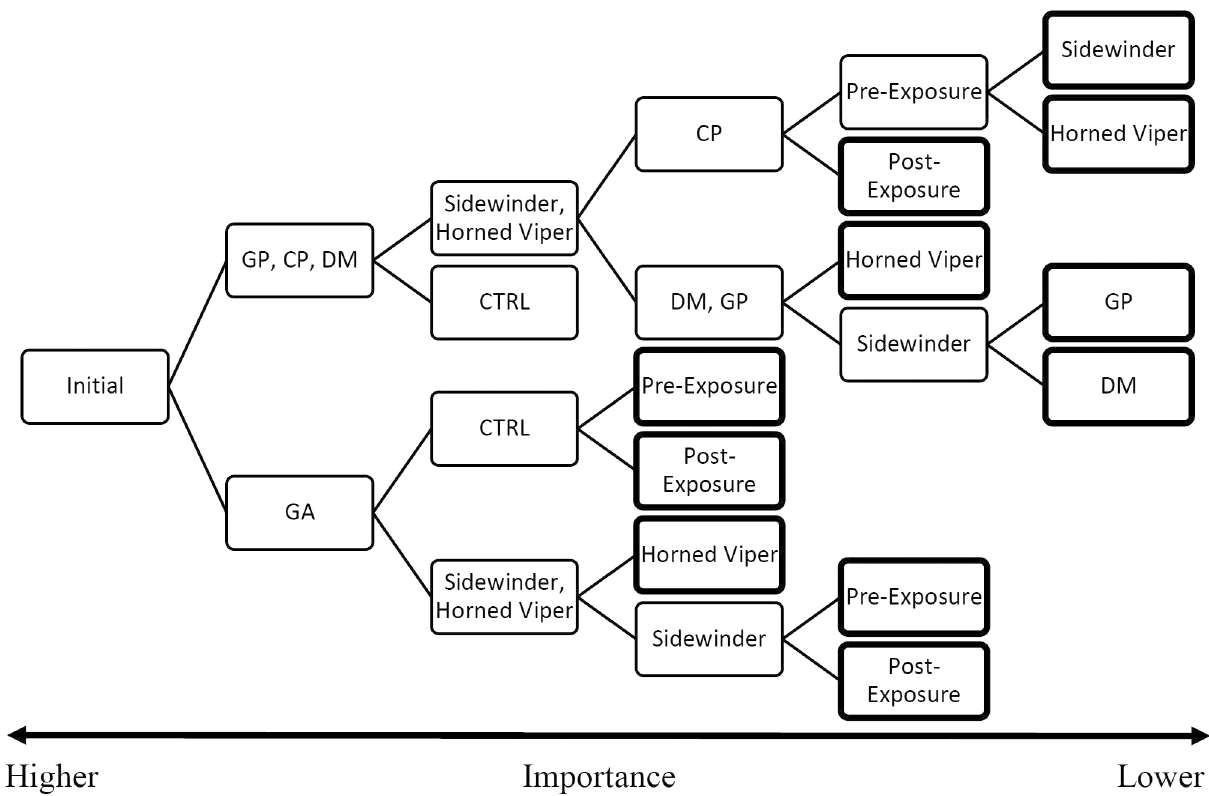
Fig 4. Random-Forest Decision-Tree with GUD as the dependent variable and species, snake-treatment and sequence as the independent variables. The figure is read from left to right with greater value to the initial nodes (left) than to final nodes marked with a bold outline.